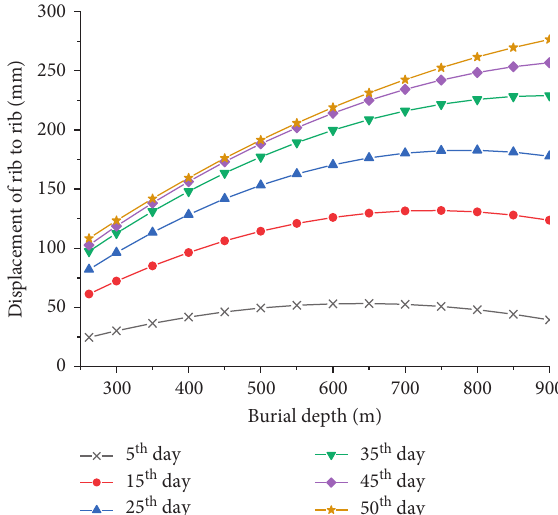
Figure 16: Comparison of displacement of